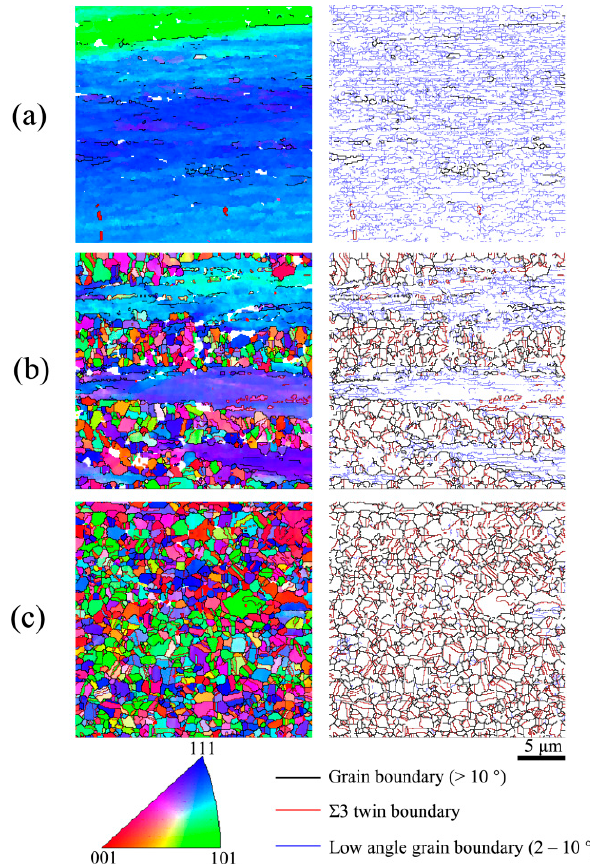
Figure 2. EBSD maps of ( a ) AR sample, ( b ) AR660 sample and ( c ) AR800 sample. Table 2. Length of LABs (2–10°) per area and Length of Σ 3Bs per area.